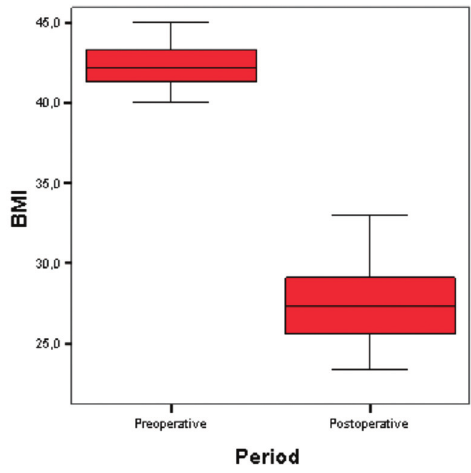
Figure 1 - Body Mass Index (preoperative and postoperative)